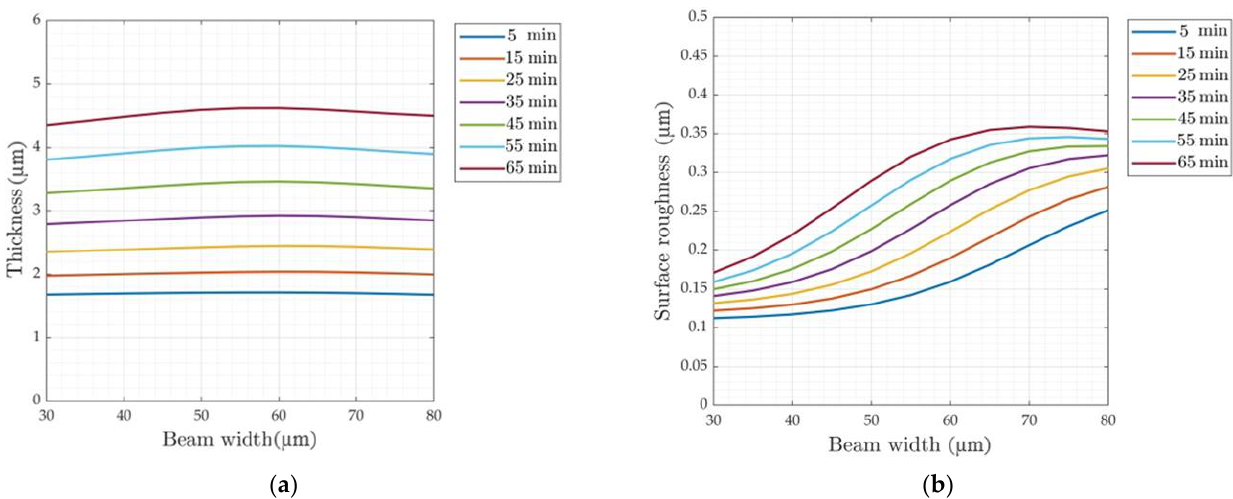
Figure 7. The results of the NN prediction on the effect of the beam width at the current density of 20 mA/cm 2 , stirring speed of 220 rpm, and RTD of 3, relative to ( a ) thickness of nickel coated layer; ( b ) surface roughness of nickel coated layer. ( b ) surface roughness of nickel coated layer.